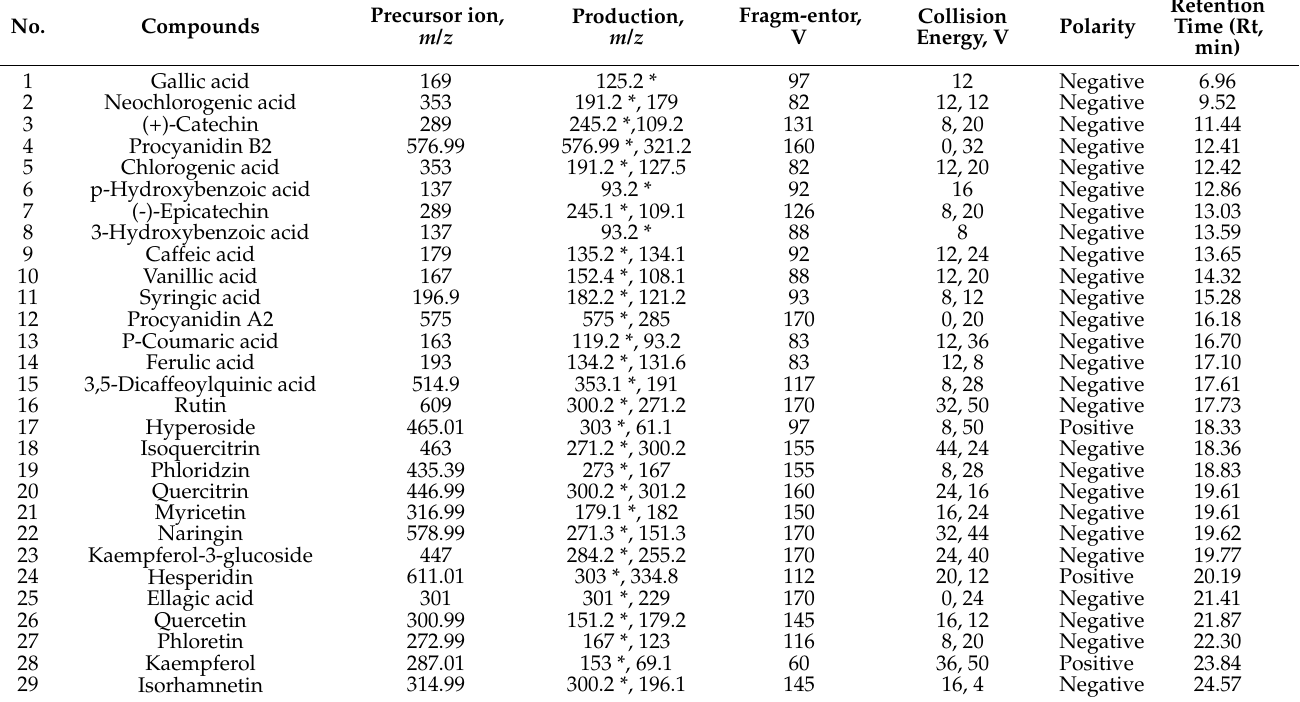
Table 1. HPLC–MS/MS acquisition parameters (dynamic-MRM mode) used for the analysis of the 29 phenolic